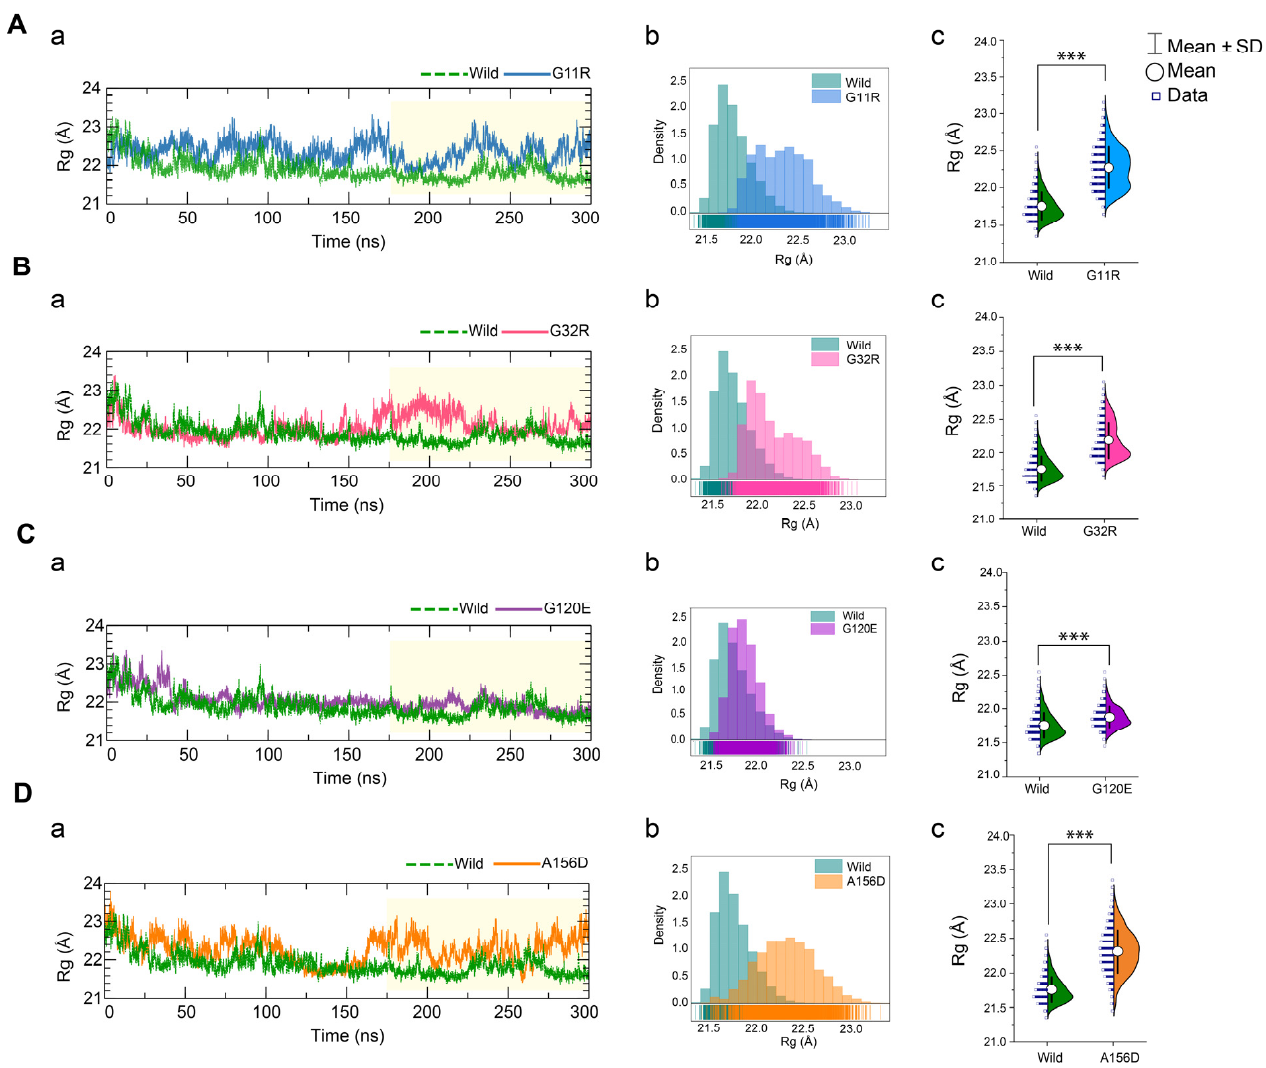
Figure 3. Analysis of radius of gyration deducing the changes in the NAGK conformational stabilities. Rg value of G11R ( A ), G32R ( B ), G120E ( C ), and A156D ( D ) variants versus wild-type NAGK, where in all cases, ( a ) represents time-dependent changes during the simulation, while ( b ) and ( c ) describe probability density and mean difference in the Rg distribution, based on the last 125 ns trajectories. The annotations used in A ( c ), B ( c ), C ( c ), and D ( c ) represent statistical significance, denoting *** p < 0.0001. Two-tailed, equal-sample variance Student’s t -tests were used to calculate the p values.